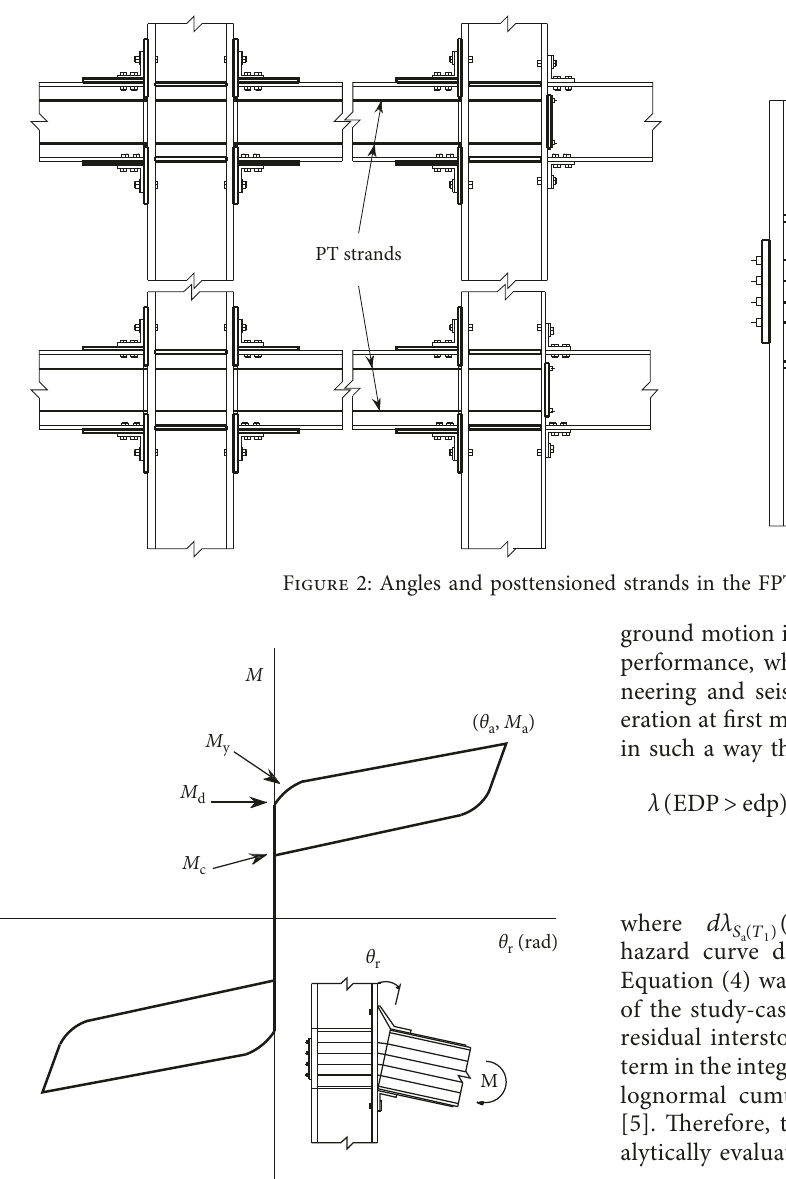
Figure 3: Moment-relative rotation hysteretic curve for the posttensioned